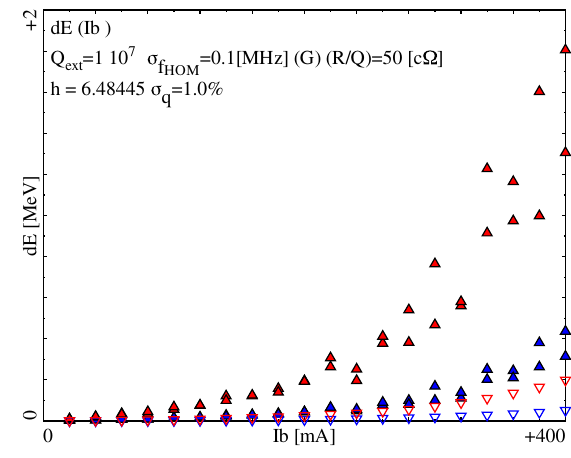
FIG. 32. (Color) dt as a function of I B for two consecutive pulses with Q ext ¼ 10 7 , (cid:1) (cid:3) f ¼ 100 kHz ; red: worst bunch in pulse; blue: rms; filled upward triangles: with 1% charge scatter; hollow downward triangles: without bunch noise.